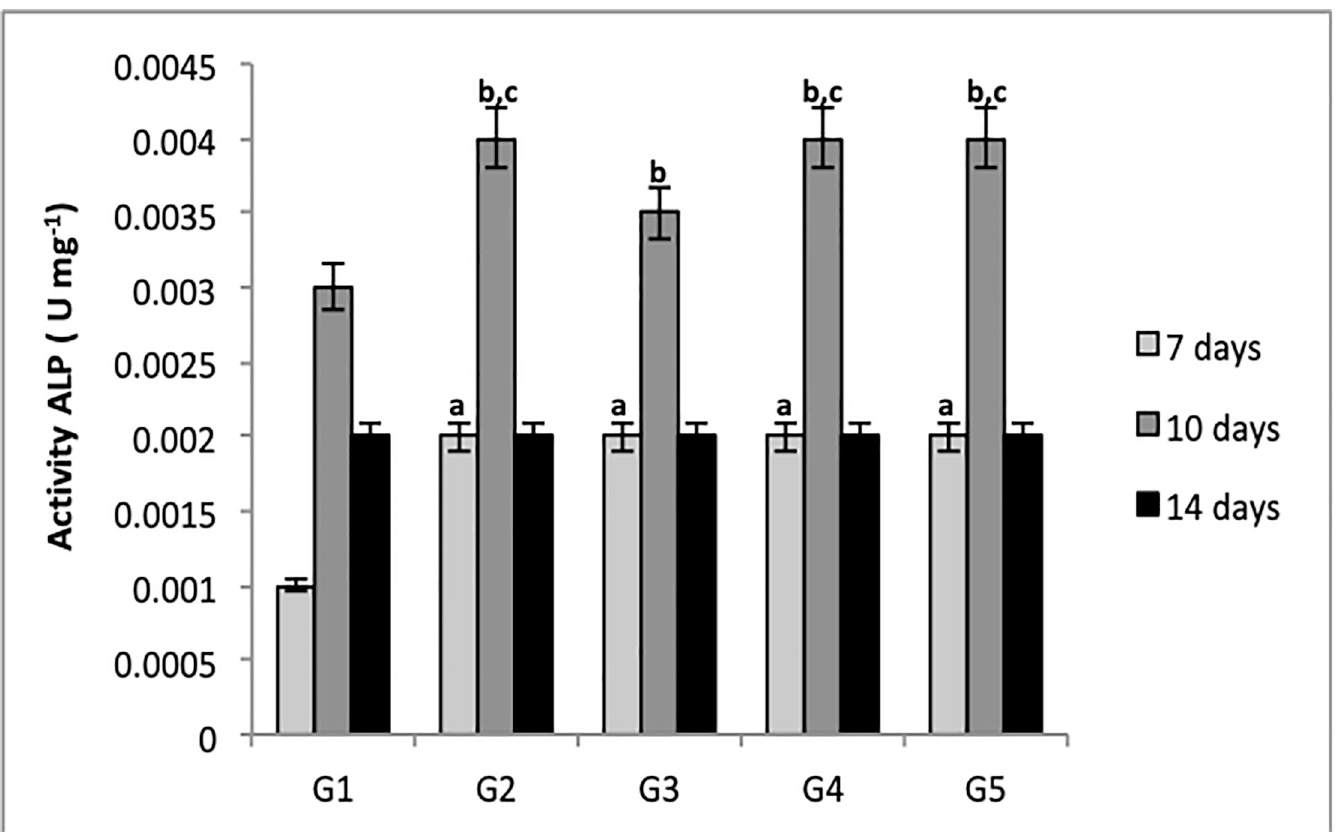
Fig 10. Quantitative analysis of ALP activity in G1, G2, G3, G4 and G5 at 7, 10, and 14 days at 595 nm. Bars indicate ALP activity according to group +/- standard error. One-way ANOVA followed by Tukey’s test. Letters indicate statistically significant differences; a = p < 0.001 compared to G1 (control group—7 days), b = p < 0.001 compared to G1 (control group—10 days), c = p < 0.001compared to